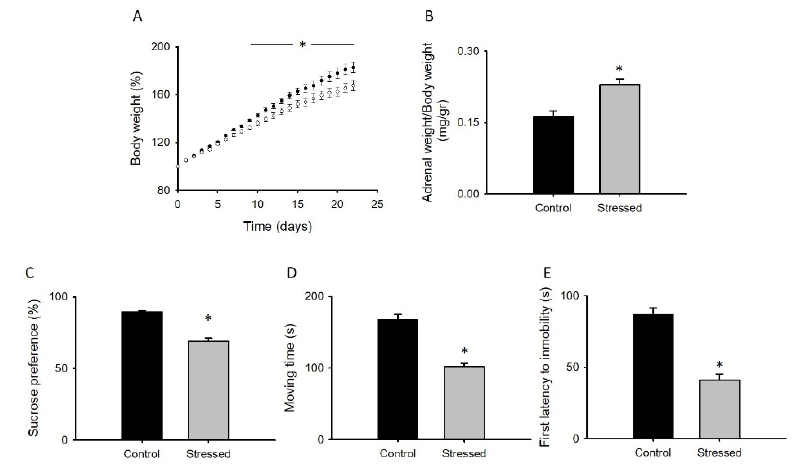
Figure 1. Rats subjected to CRS display behavioral modifications. ( A ) Body weight gain recorded daily of control animals (black circles) or rats during three weeks of CRS protocol. Bar graphs of adrenal glands weight normalized by total body weight ( B ), sucrose preference shown as percentage of sweetened water consumed with respect to the total consumed water ( C ). D and E shows the total time of swimming and climbing ( D ), and the latency to the first period of immobility ( E ) of animals during the forced swimming test. Bar graphs are mean ± SEM; black bars are control animals, and gray bars correspond to CRS-subjected animals. n > 9 * p value < 0.05.